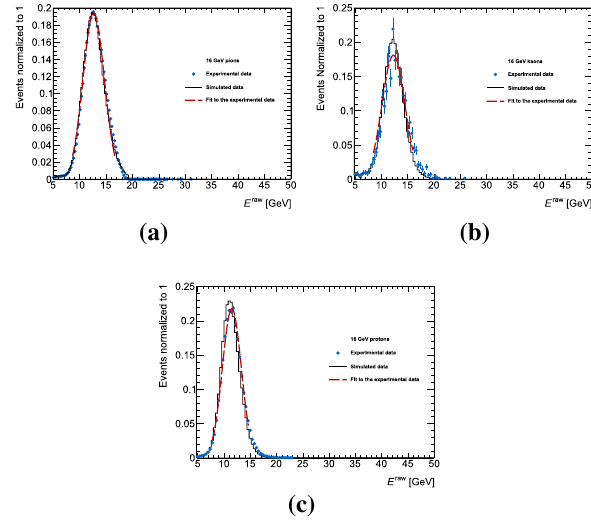
Fig. 16 Distributions of the reconstructed energy E raw obtained ana- lyzing pion ( a ), kaon ( b ) and proton ( c ) data with E beam = 16 GeV. The blue dotted histograms represent the experimental data. Only statistical uncertainties are shown. The dashed curves in red correspond to the fit of a Gaussian function to the experimental data in a region ± 2 σ around the peak value. The black histograms correspond to the predictions of the MC simulation